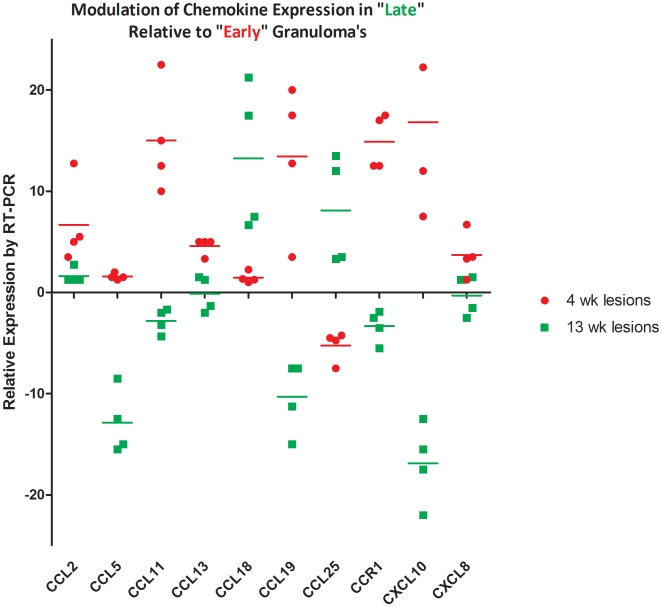
Confirmation of transcriptome results by RT-PCR.Quantitative real-time Reverse-Transcriptase (RT-PCR) arrays specific for chemokines and their receptors were used to confirm microarray results. Biologically independent samples from all three “early” and “late” animals (different from those used in microarray experiment) were pooled into two groups, and duplicate analysis performed using PCR arrays. GAPDH was used as the invariant housekeeping control for normalization. Numeric fold changes reflect the following difference: [Gene x lesion lung (week 4 or week 13) – 18S RNA lesion lung (week 4 or week 13)] – [Gene x normal lung (week 4 or week 13) – 18S RNA lesion lung (week 4 or week 13)]. The expression of CCL25 was checked by conventional SyBr green RT-PCR, using the Applied Biosystems (Foster City, CA) Fast SYBR Green kit since it was not included in the PCR array. Data was analyzed in a manner comparable to PCR-arrays.